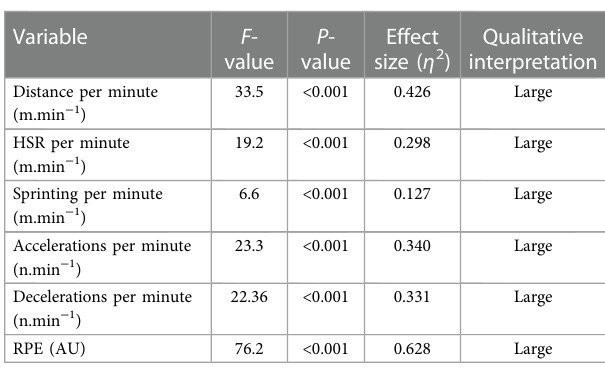
TABLE 1 Comparison between training load parameters during different drills.